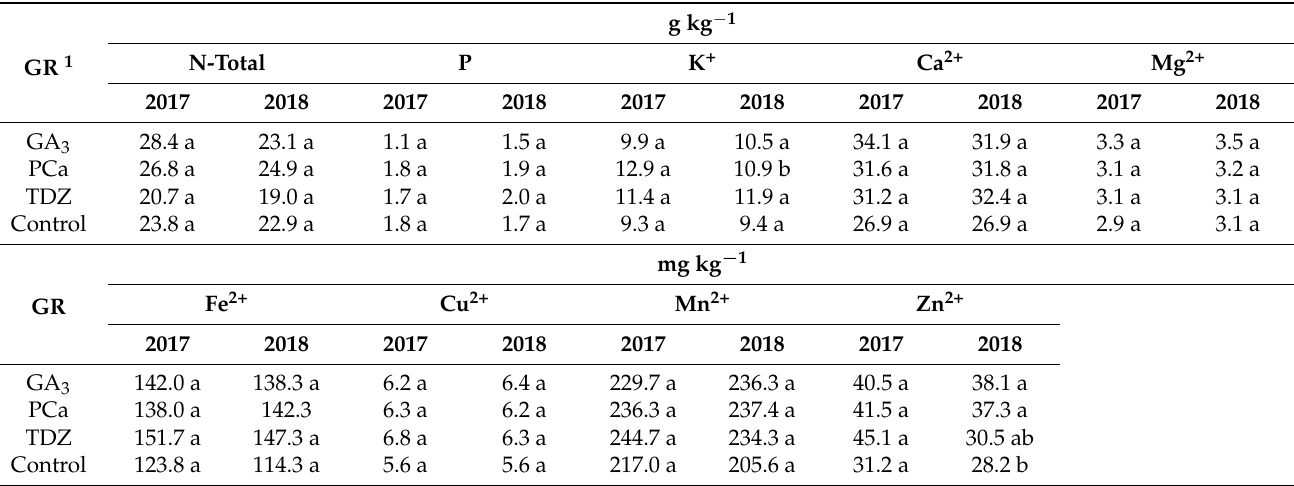
Table 2. Concentration of nutrients in pecan leaflets cv. “Wichita” with applications of GR.